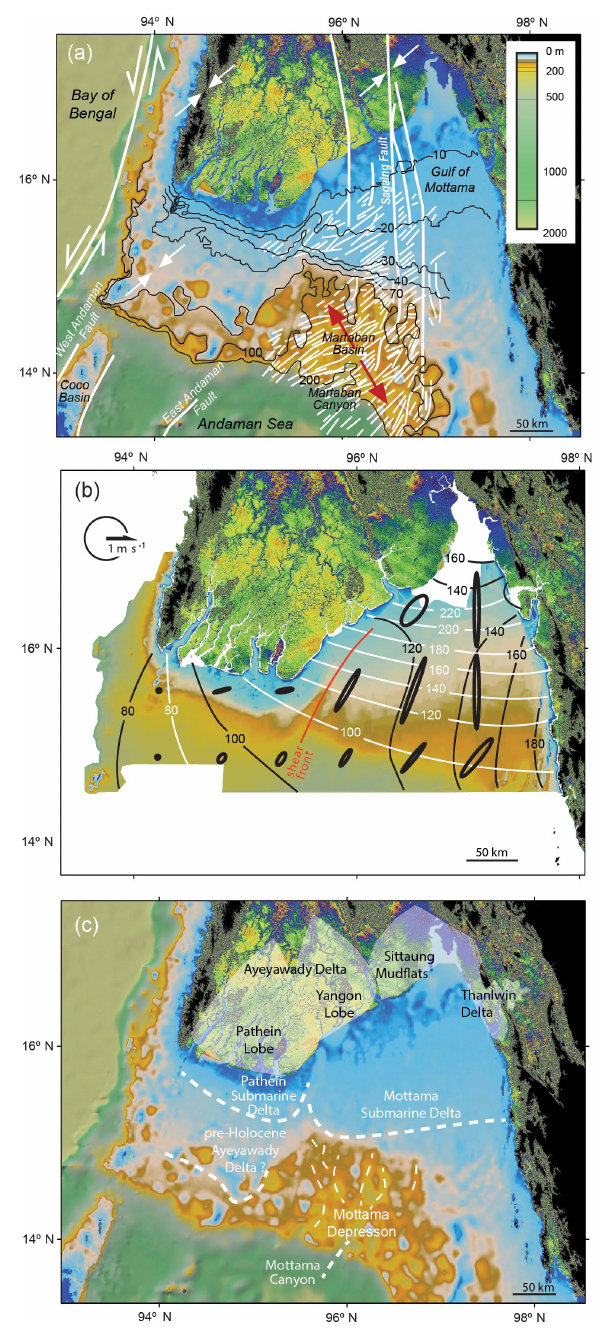
Figure 5. (a) Bathymetry of the northern Andaman Sea shelf and SRTM-derived DEM for the Ayeyawady delta region on land with regional faults and associated splay faults (Morley, 2007); ar- row pairs indicate regional compression (white) or extension (red); (b) tidal range lines (black), cotidal lines (white) and tidal current magnitudes (ellipses) for the dominant M2 tide component (Rizal et al., 2012); (c) sketch of the Ayeyawady delta plain evolution phases and associated subaqueous